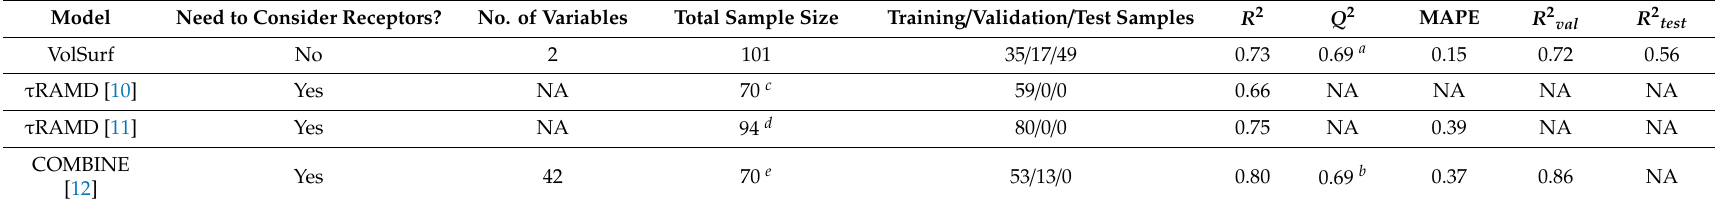
Table 2. Performance comparison among VolSurf, τ -random acceleration molecular dynamics ( τ RAMD) and COMBINE models.